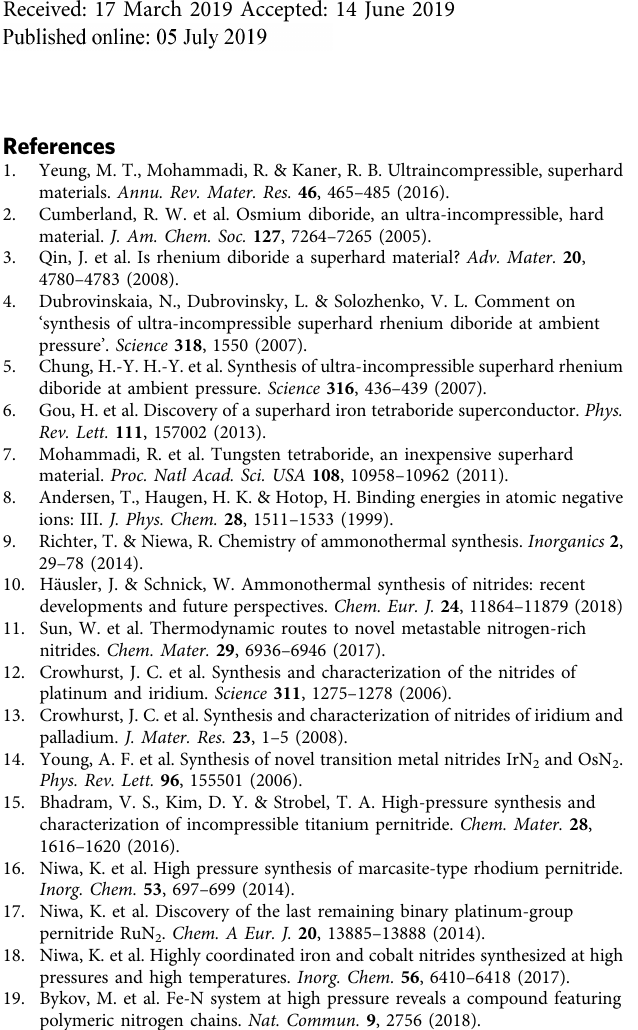
Figshare (https:// fi gshare.com/) with the accession link https://doi.org/10.6084/m9. fi